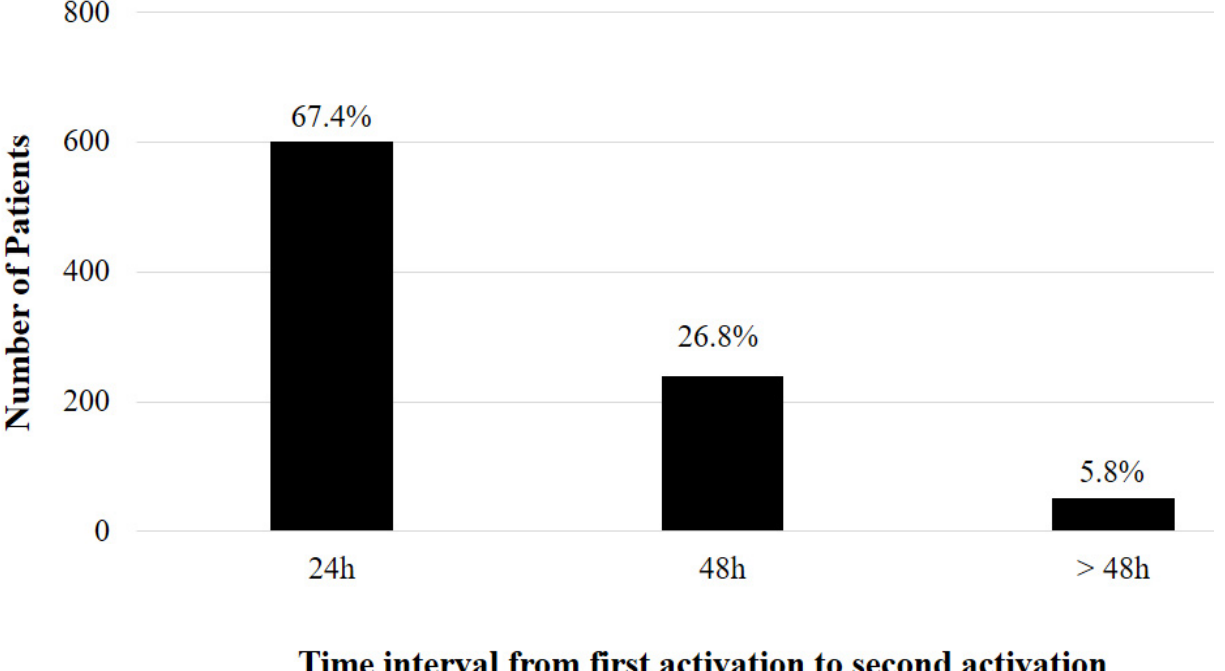
Table 1. Baseline characteristics of the patients at time of contact with medical emergency team.